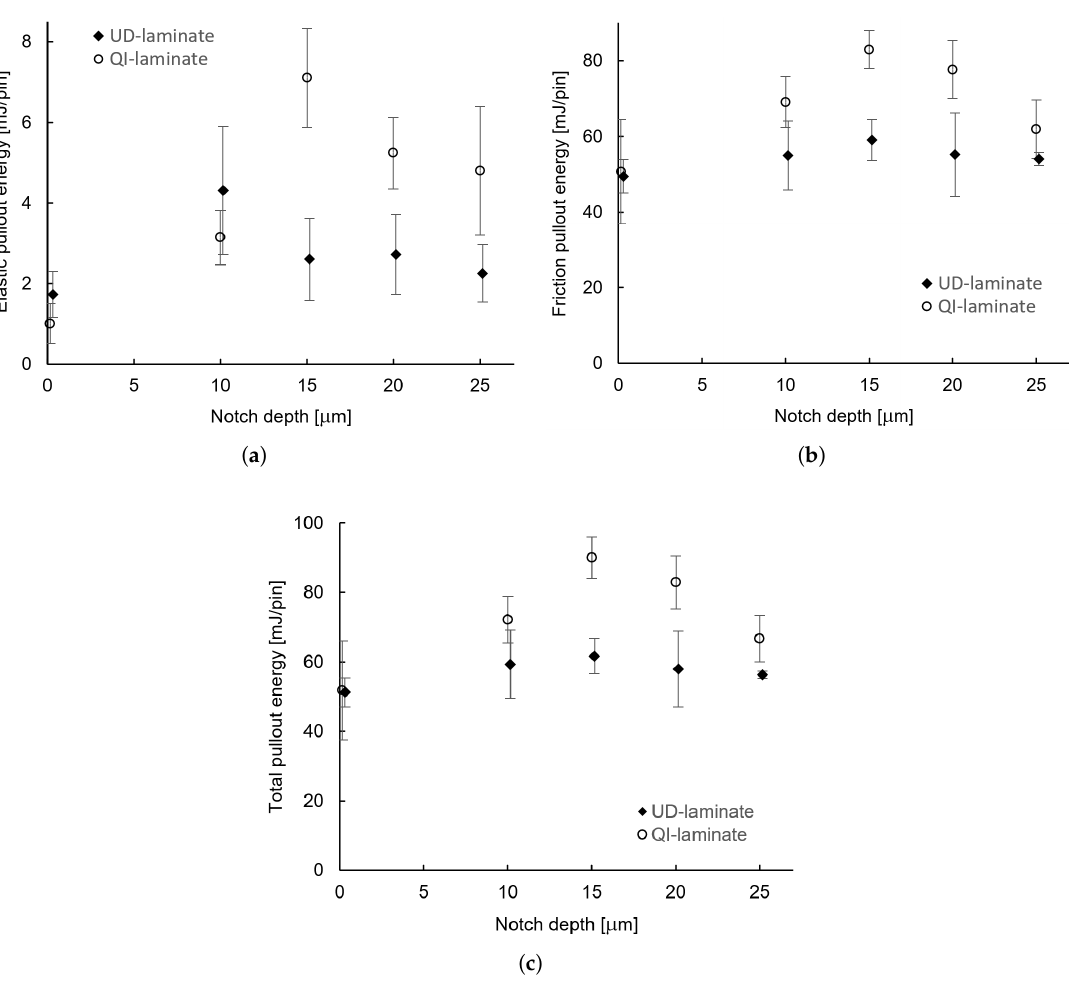
Figure 9. Mean values and corresponding standard deviation of elastic ( a ), friction ( b ), and total ( c ) pullout energy dissipated during z-pin pullout of unnotched and circumferentially notched z-pins with circular notch design and different notch depths in unidirectional and quasi-isotropic